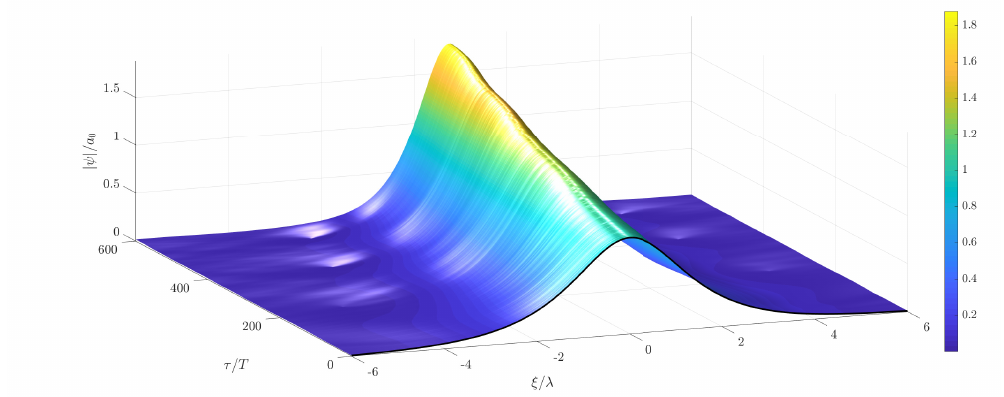
Figure 13. Temporal evolution of a soliton solution of the stochastic MNLS with non-white noise excitation in time, mean wind velocity V m = 14 m/s and σ v = 5